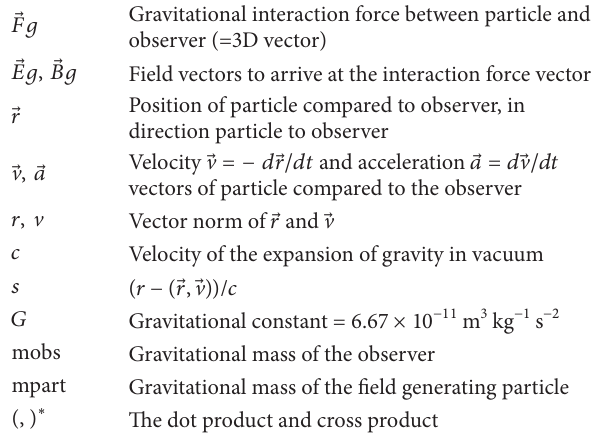
Figure 2: Coordinate definitions. Observer is in the center of the universe.